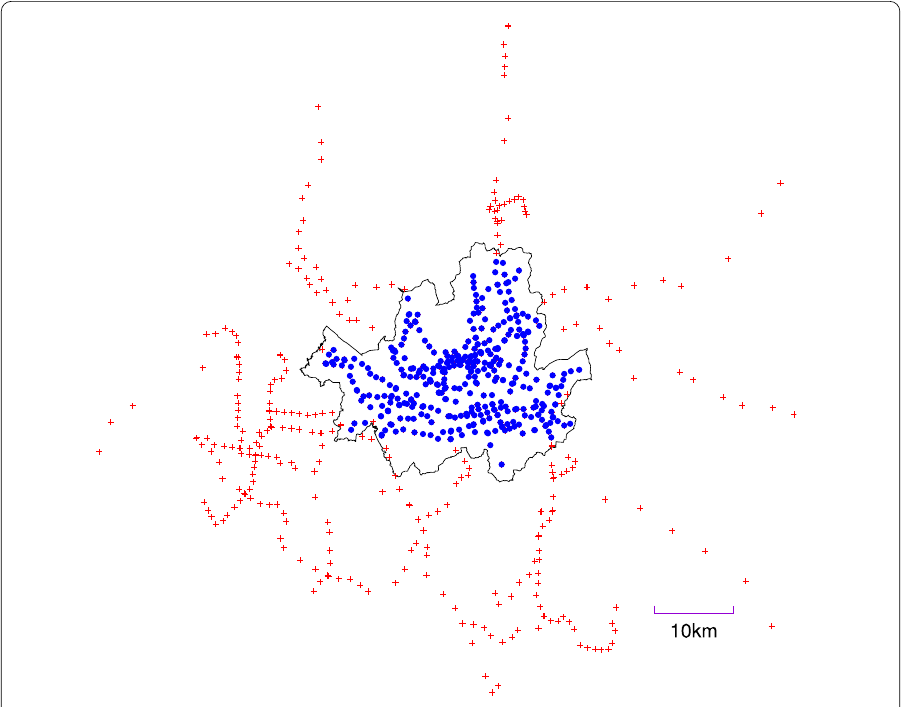
Figure 1 SeoulMetropolitanSubwaysystem . Each station is represented by a (blue or red) dot whereas the (black) solid line depicts the boundary of Seoul City. Accessibility, as well as the number of passengers at each station, is obtained from the data for the whole subway system. In the case of population, 289 stations (blue dots) inside Seoul out of 615 stations are used since the population data are available only for